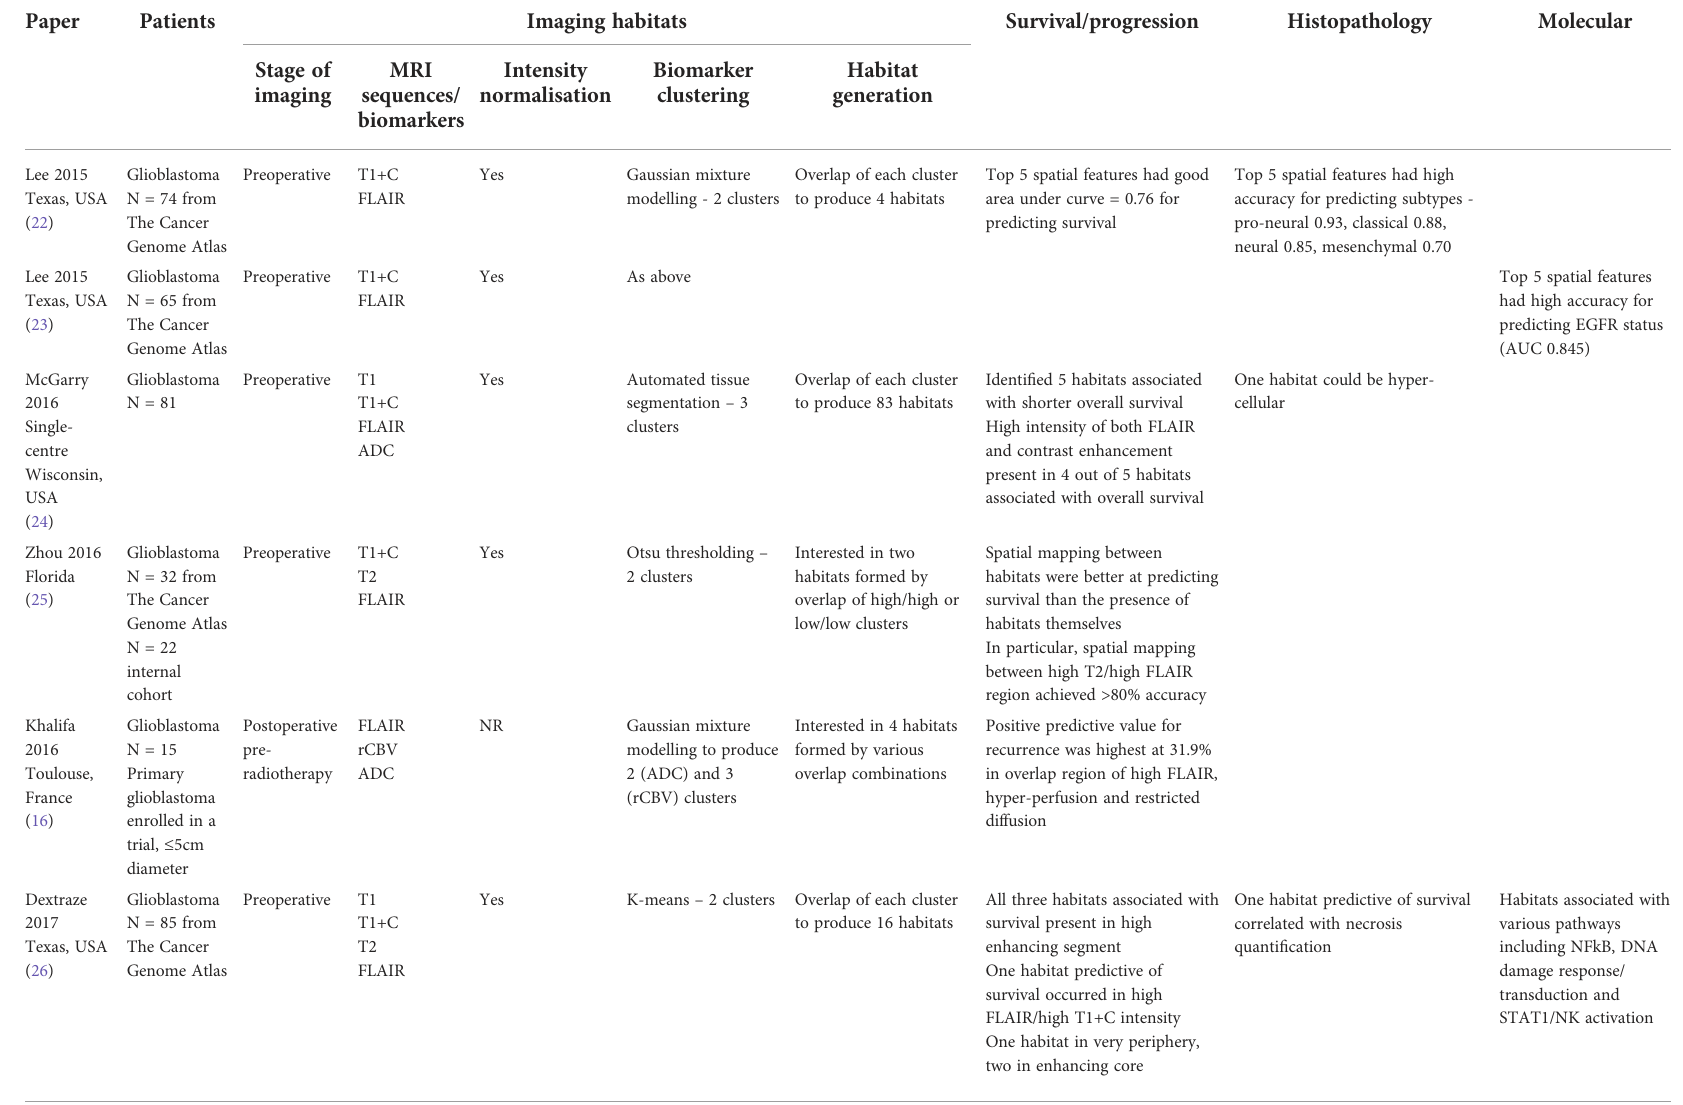
TABLE 2 Habitat imaging in glioblastoma: the current